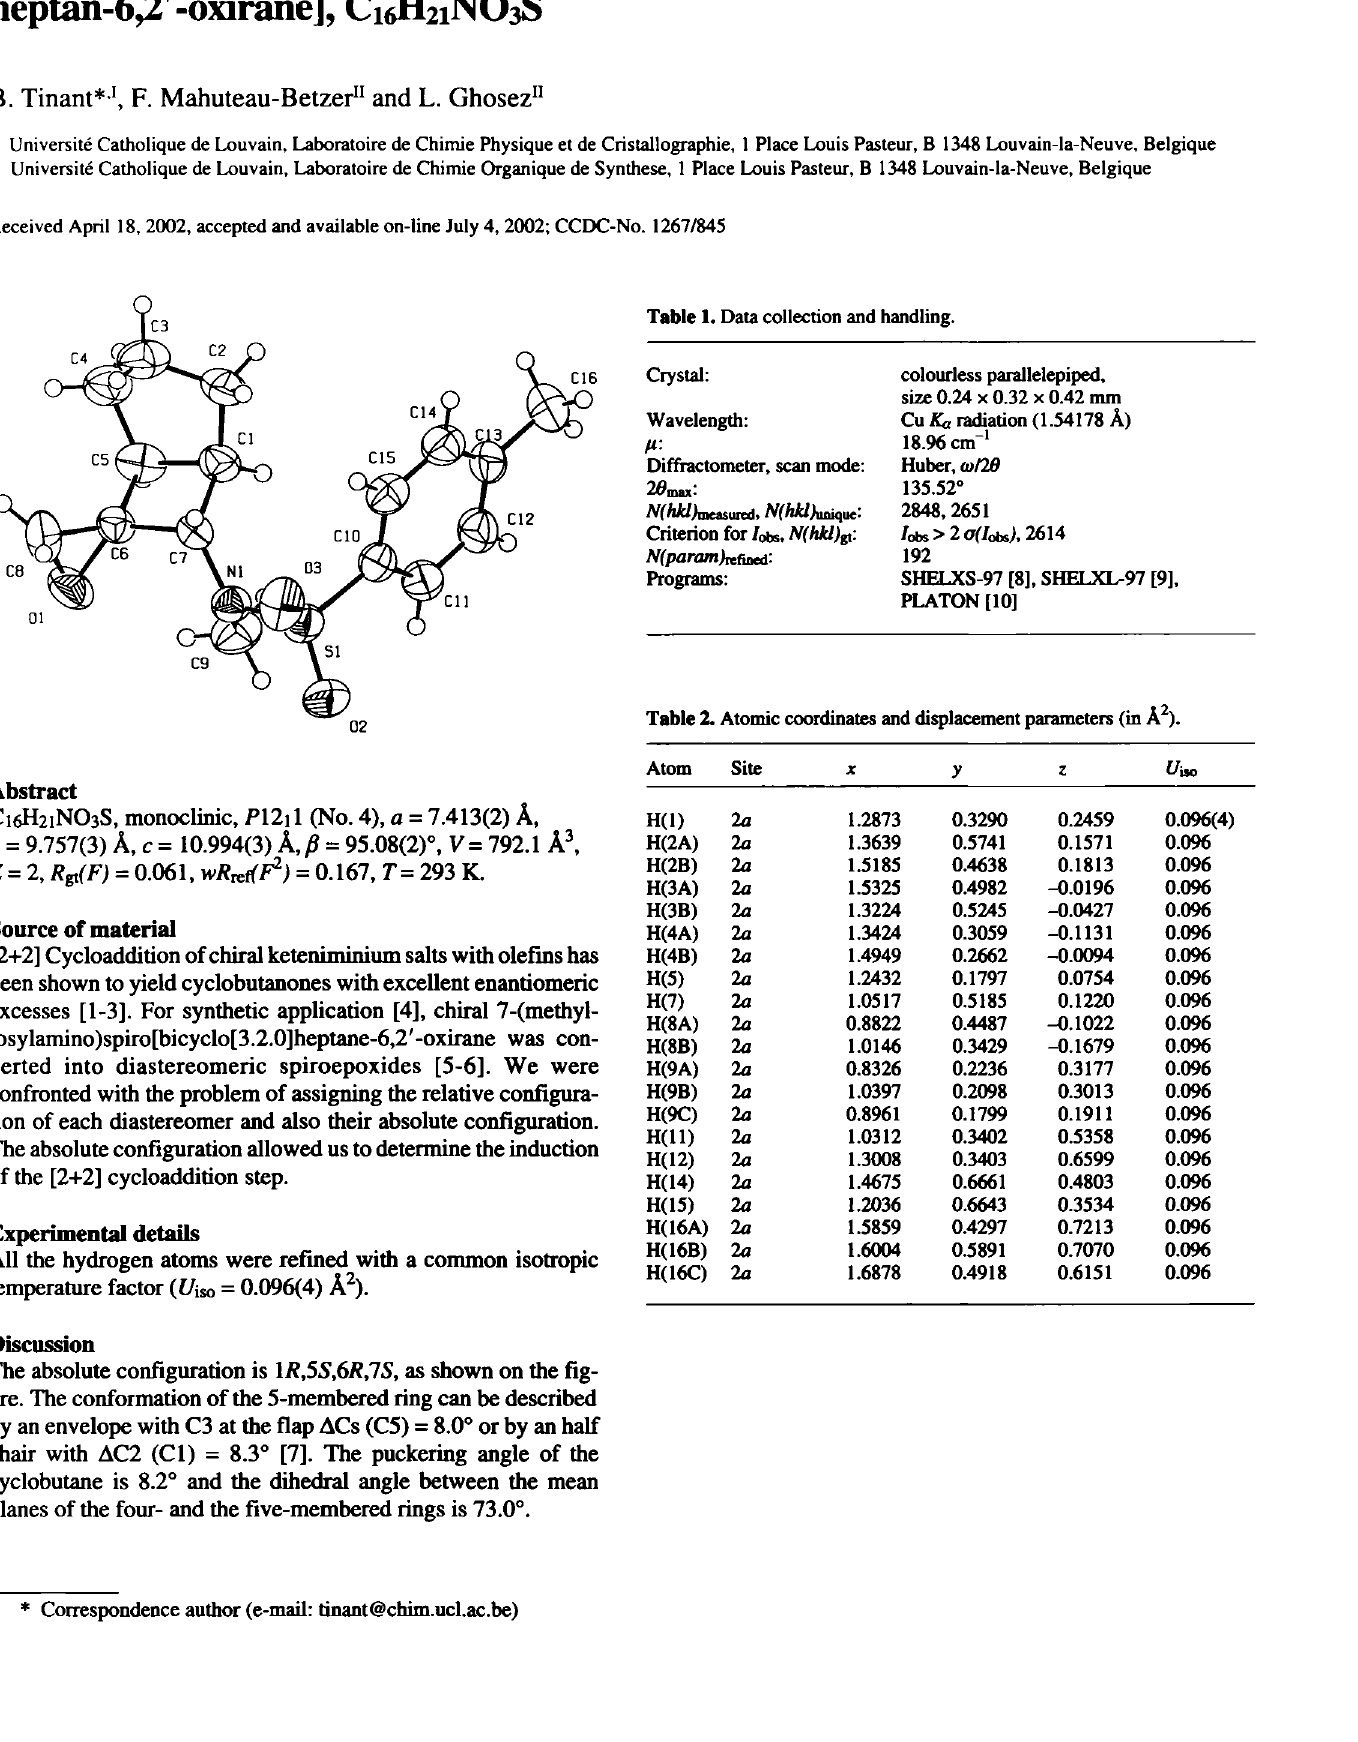
Table 2. Atomic coordinates and displacement parameters (in À 2